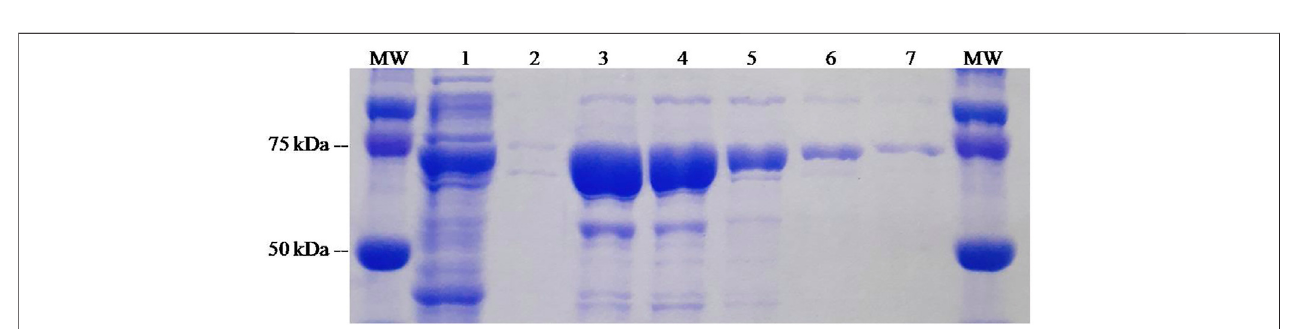
FIGURE 2 | SDS-PAGE of the puri fi cation process of ZZ-Amy fusion-protein: (MW) molecular weight standard; (1) crude extract of E. coli expressing ZZ-Amy; (2) void volume; (3) elution 1; (4) elution 2; (5) elution 3; (6) elution 4; (7) elution 5.